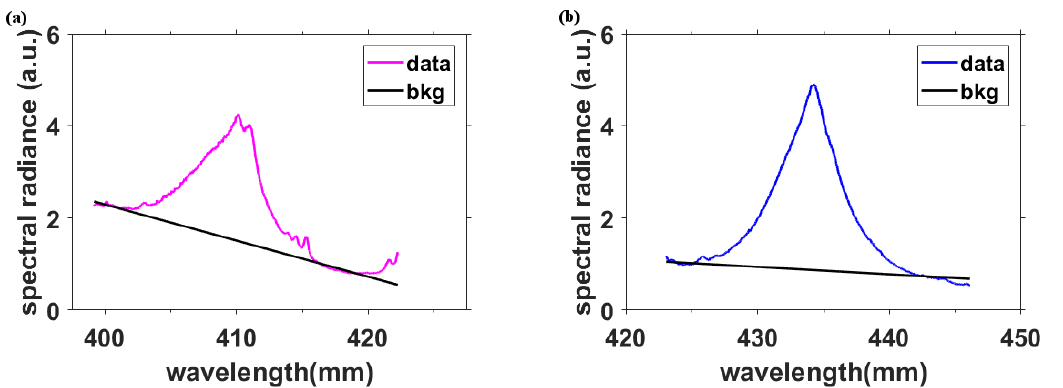
Figure 7. Measured line shapes at a time delay of 1.5 µ s. ( a ) H δ and ( b ) H γ